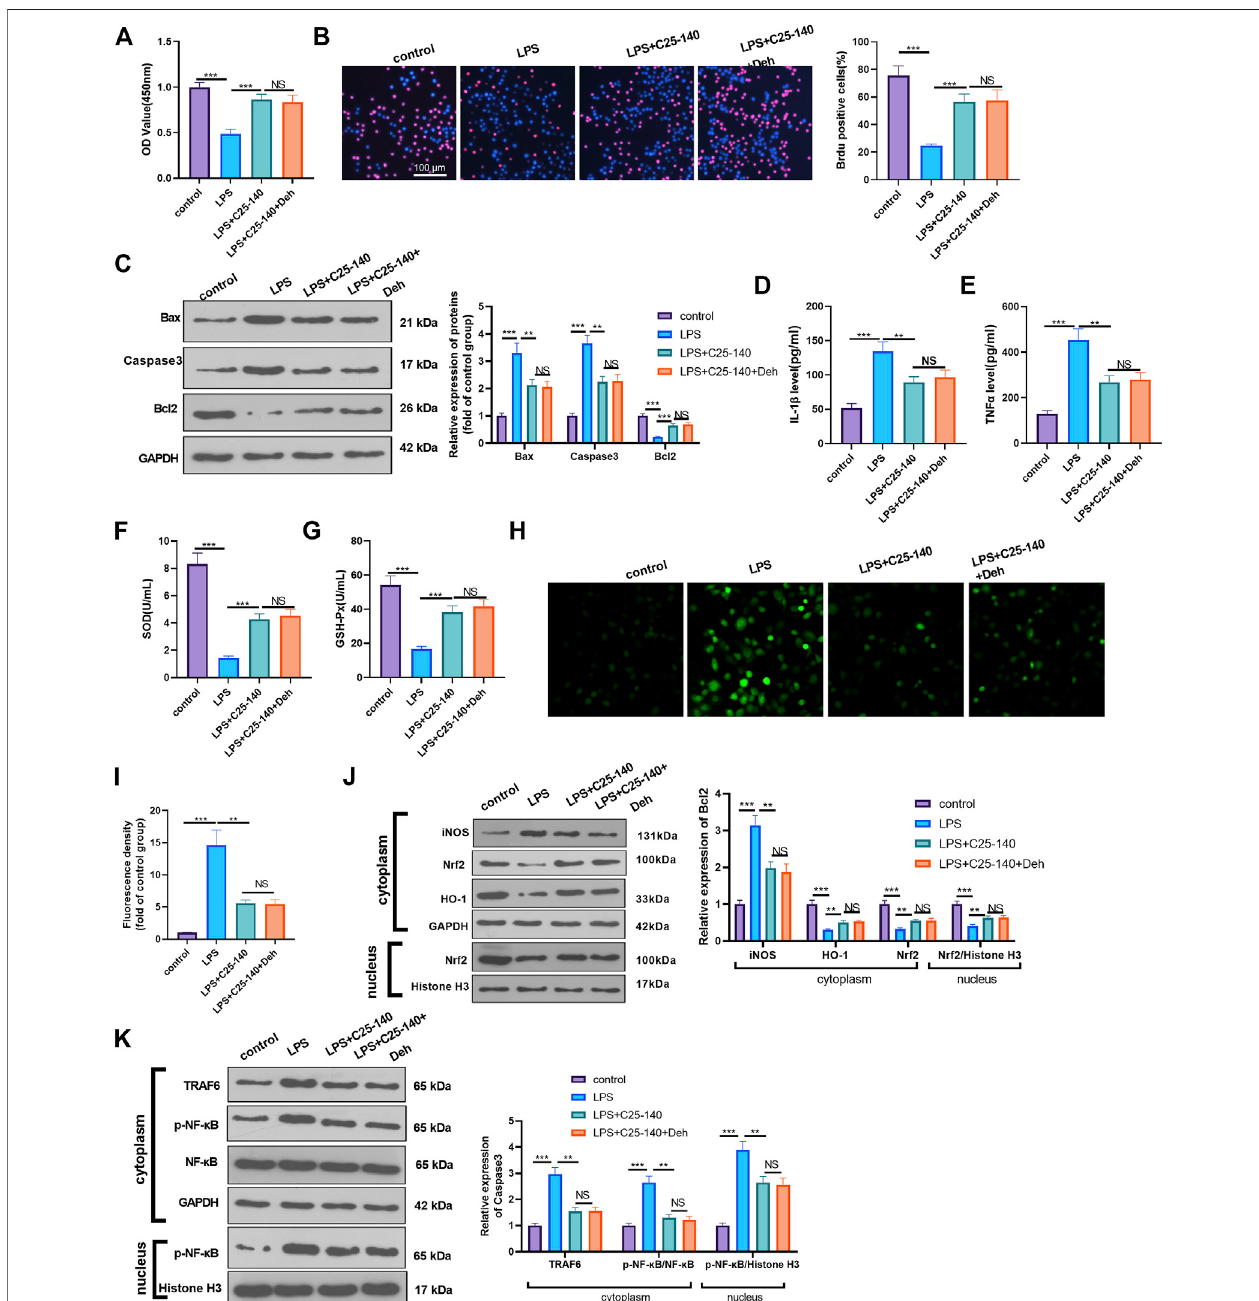
FIGURE 5 | Inhibition of TRAF6 attenuated LPS-mediated myocardial injury. The H9C2 cardiomyocytes were pretreated with C25-140 (5 μ M, an inhibitor of TRAF6) for 2 h and then treated with LPS (10 μ g/ml) and Deh (10 μ g/ml) for 24 h (A, B) CCK8, and BrdU assay were taken to detect the cell viability of each group. The rate of BrdU positive cells (red)/nucleus (blue) was calculated. (C) Western blot was performed for the detection of Bax, Caspase3 and Bcl2 expressions in cardiomyocytes. (D, E) ELISA method was employed to evaluate IL-1 β and TNF α levels in the culture medium of each group. (F, G) The SOD and GSH-PX detection kits were applied to detect SOD (G) and GSH-PX (H) levels in the culture medium of each group. (H, I) . The ROS level in H9C2 cells were evaluated using the DCFDA/H2DCFDA - Cellular ROS Assay Kit. (J, K) . The protein level of iNOS, Nrf2/HO-1, TRAF6, and p-NF- κ B in the whole cell or nucleus of heart was detected by western blot. nsP > 0.05, ** p < 0.01, *** p < 0.001. N (cid:1) 3.